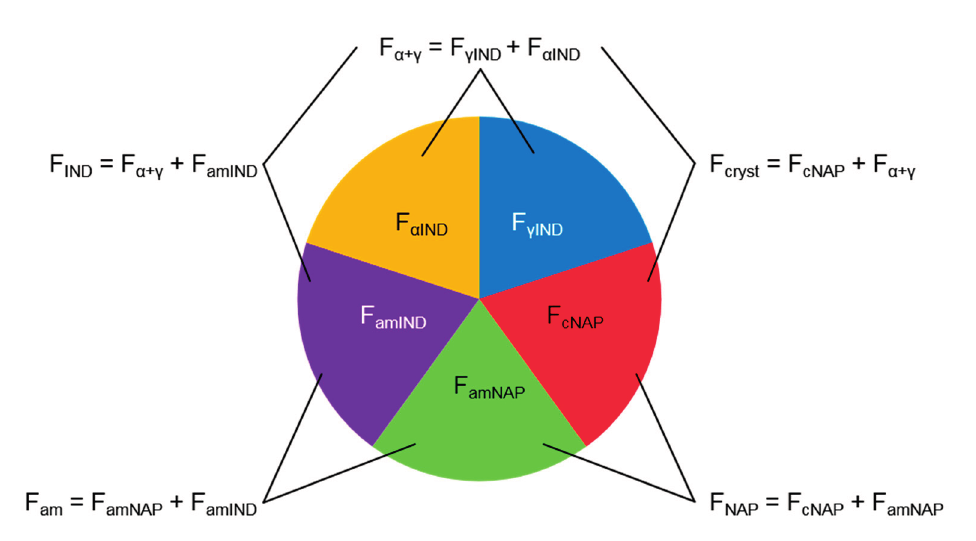
Figure 1. Circular chart showing the phases that can be present during the recrystallization of co-amorphous naproxen-indomethacin. The different colors represent the molar fractions of cNAP (F cNAP ), γ -IND (F γ IND ), α -IND (F α IND ), amorphous NAP (F amNAP ) and amorphous IND (F amIND ). F am represents the total molar amorphous fraction, F α + γ the total molar crystalline IND fraction, F cryst the total molar crystalline fraction, F IND the total molar IND fraction and F NAP the total molar NAP